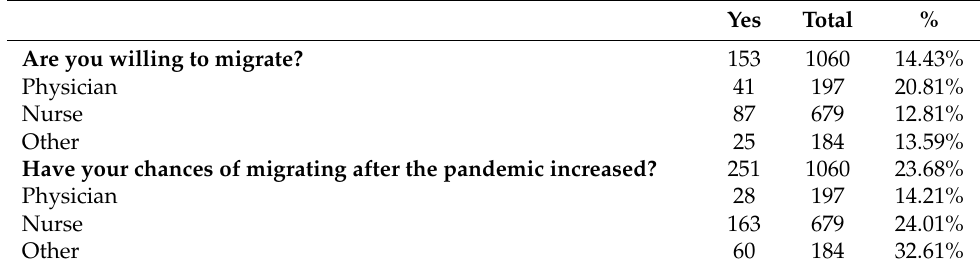
Table 2. Summary results of migration intent among healthcare